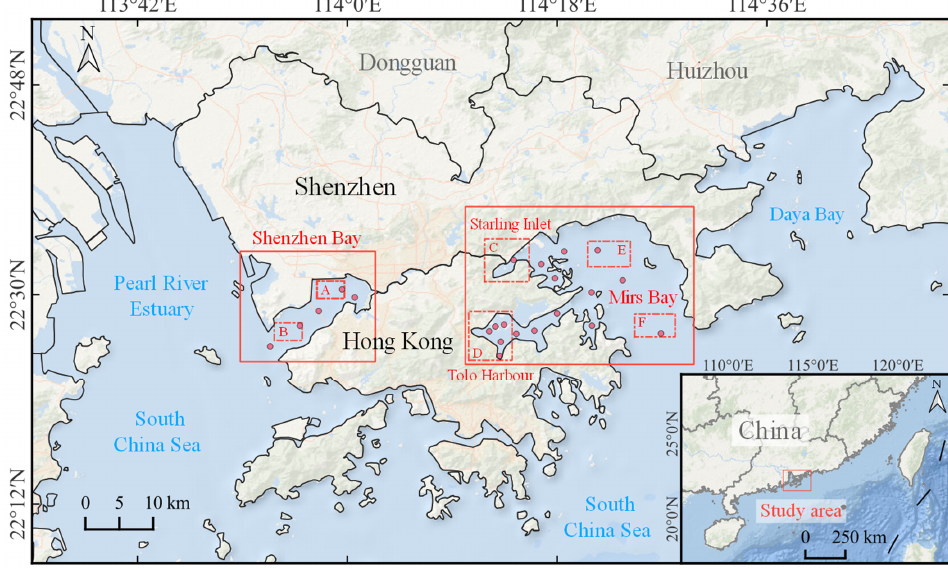
Figure 1. Map of the study area and the monitoring areas (A–F). Red dots = stations.